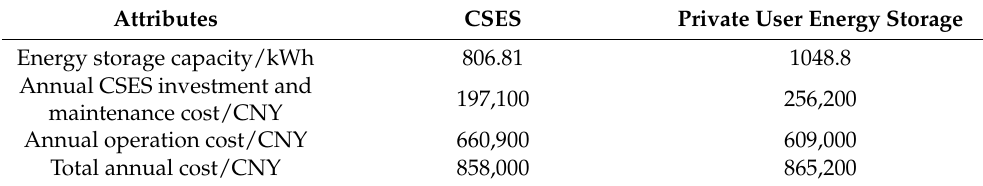
Table 5. Simulation results for CSES and private user energy